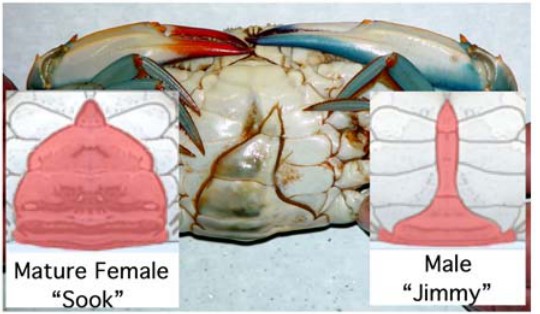
Figure 8. Ventral view of the gynandromorph blue crab. This ventral view of the gynandromorph blue crab shows its apron with its female side resembling the ‘‘Capitol dome’’ shaped apron of a normal female. The male side apron resembles the ‘‘Washington monument’’ shape of a normal male. The two drawing are included for comparison to normal female and male